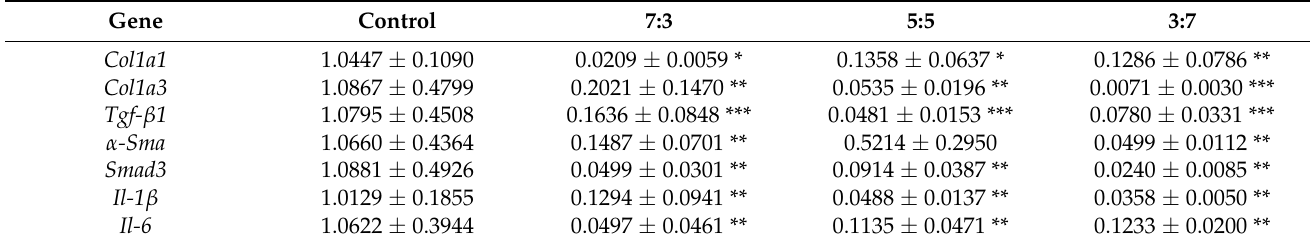
Table 2. Relative mRNA gene expression in PDMS coated with